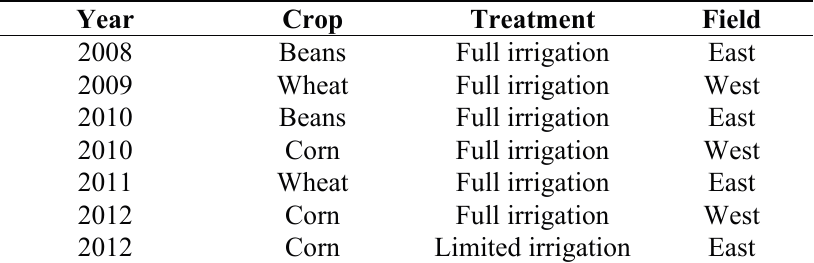
Table 1. Crops grown at LIRF and used to test SEBAL-A.